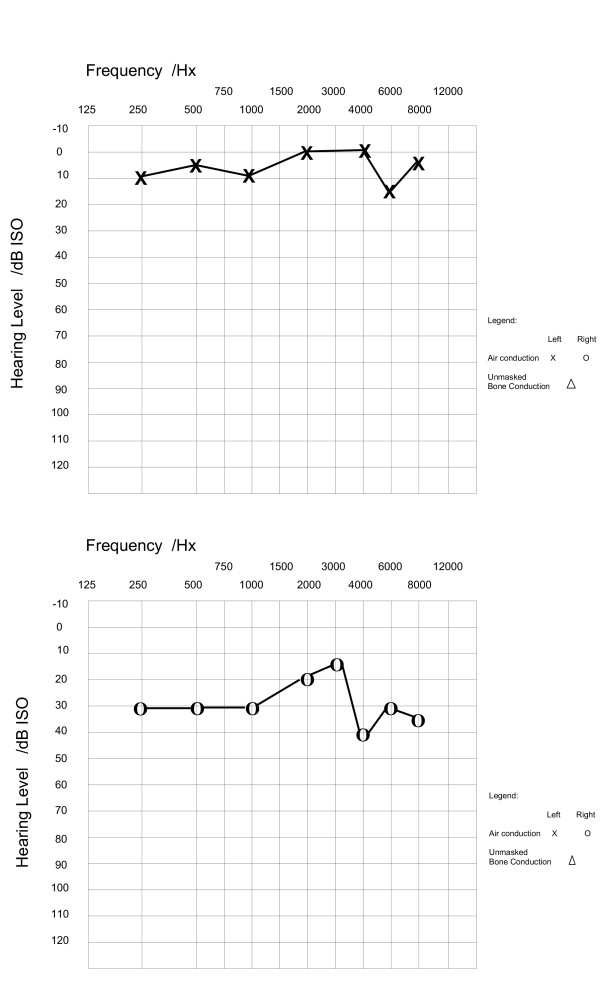
Post-operative pure tone audiogram.